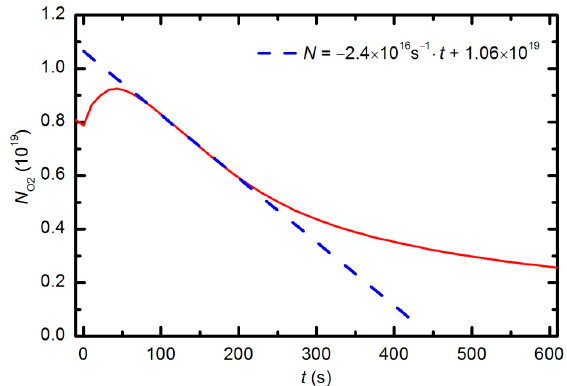
Figure 16. The slope of the oxygen partial pressure during the first few minutes of plasma treatment at 33 Pa and 150 W.